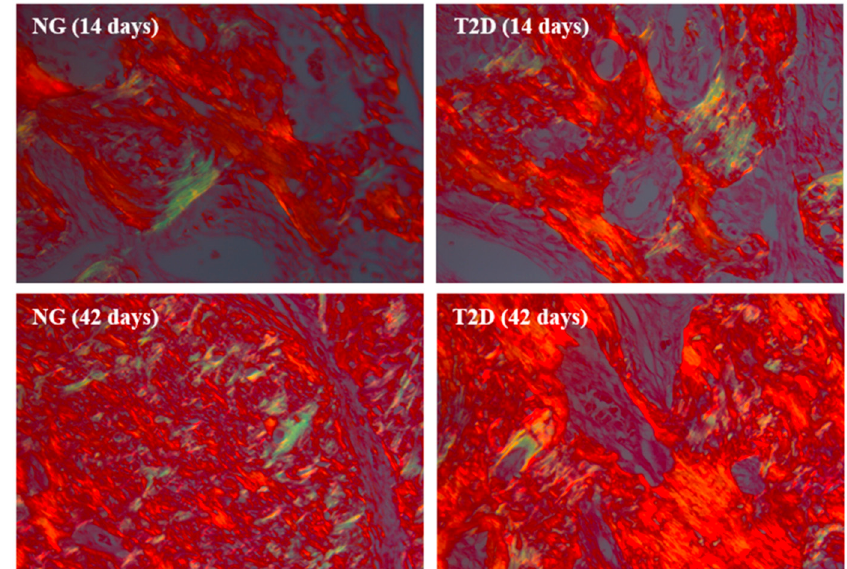
Figure 5. Collagen maturation photomicrographs. Photomicrographs at 14 and 42 days after dental extraction obtained by a polarized microscopy, showing birefringent collagen fibers in the green and red shades, representing a less organized and immature collagen matrix and a more organized mature collagen matrix, respectively. Counterstaining: Picrosirius red. Original 25× magnification.